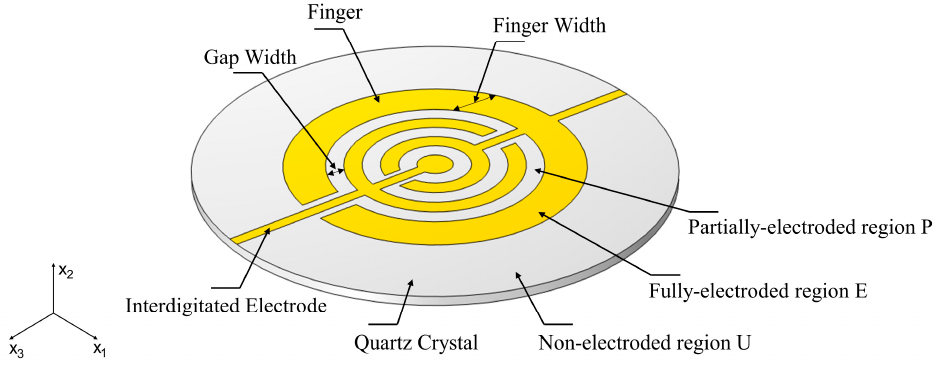
Figure 1. Structure of QCM with ring-shaped interdigital